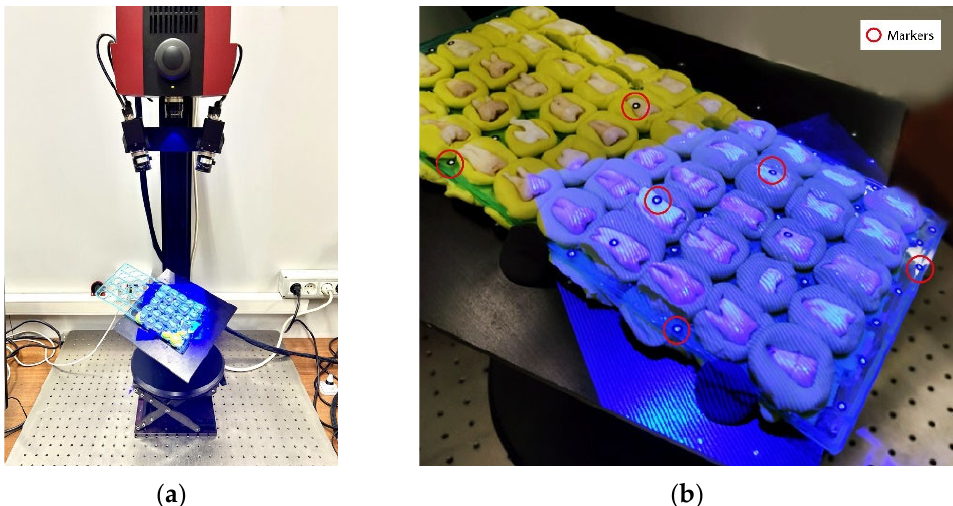
Figure 1. ( a ) GOM Atos Compact Scan. ( b ) Scanning process by structured light fringes with indi ‐ cation of some markers